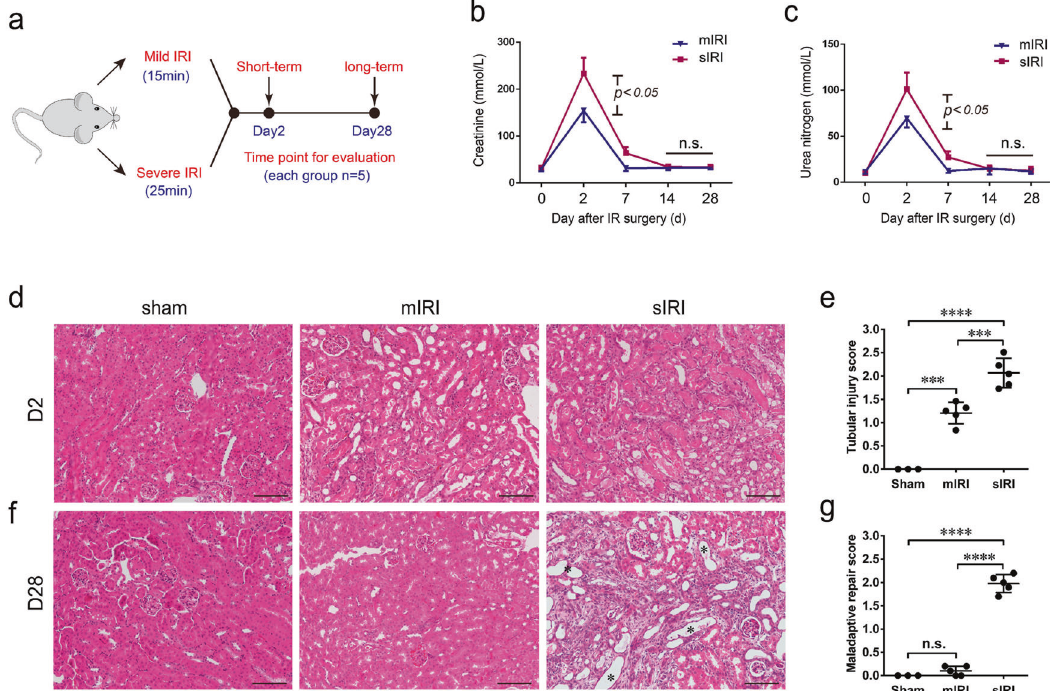
Fig. 1 Short- and long-term outcomes after mild or severe IRI-induced AKI. a Schematic of the design of mild and severe AKI mice model. The mild and severe AKI were induced by 15 and 25 min of renal ischemic durations, respectively. Short- and long-term outcomes were evaluated in 2 and 28 days after surgery. b Serum creatinine and c blood urine nitrogen levels of two group mice subjected to mild and severe renal IRI at indicated time points. n = 5 for mild AKI and severe AKI mice, respectively. d Representative images of the renal cortex 2 days after surgery stained with HE. e Semi-quantitative scoring of renal tubular damage in kidneys at 48 h after surgery considering tubular dilation, brush border loss, tubular degeneration, tubular cast formation, and tubular necrosis. f Representative images of the renal cortex 28 days after surgery stained with HE. Asterisk represents the renal maladaptive-repaired tubules. g Semi-quantitative scoring of renal maladaptive repair in 28 days after surgery considering tubular atrophy, brush border loss, tubular degeneration, interstitial fi brosis. n = 3 mice for the sham group, n = 5 for mild and severe AKI per time-point group, respectively. Data are mean ± SD. *** P < 0.001, **** P < 0.0001. ns not signi fi cant. d , f Bar = 50